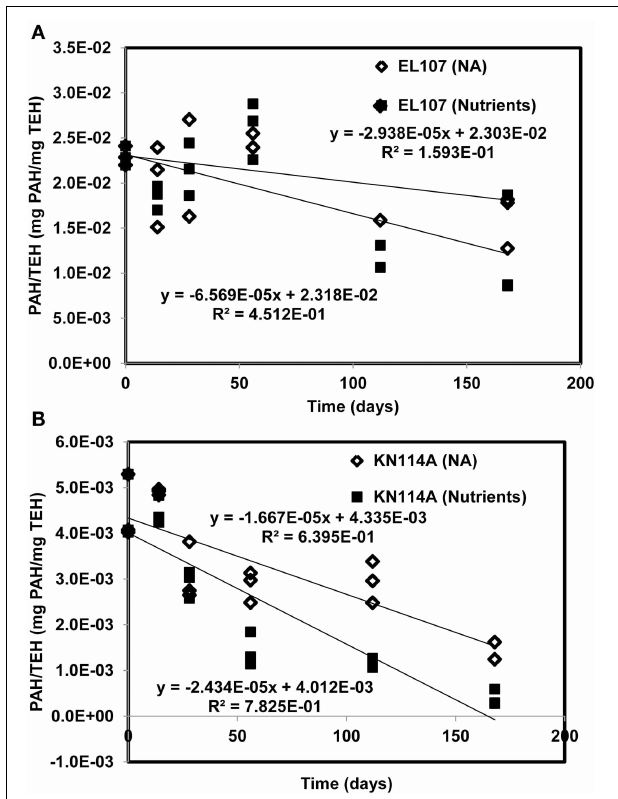
FIGURE 11 | PAH concentration normalized by the concentration of total extractable hydrocarbon (TEH) as function of time for (A) EL107 and (B) KN114A. Fitted straight lines were obtained to determine if there is a correlation between the biodegradation of PAH and that of